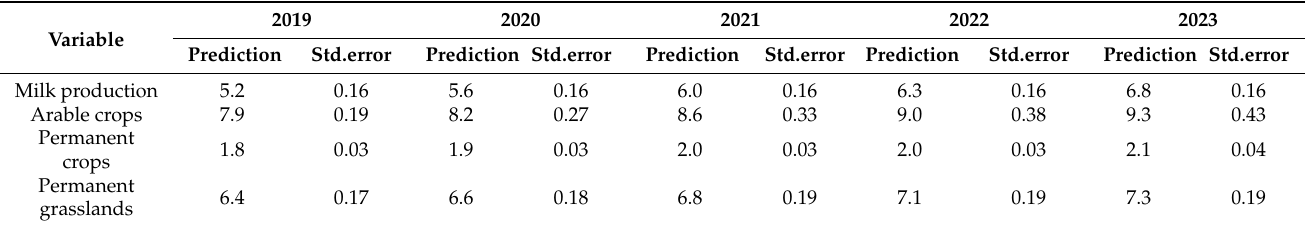
Table 5. Prognosis of organic milk production and organic land in the years 2019–2023.